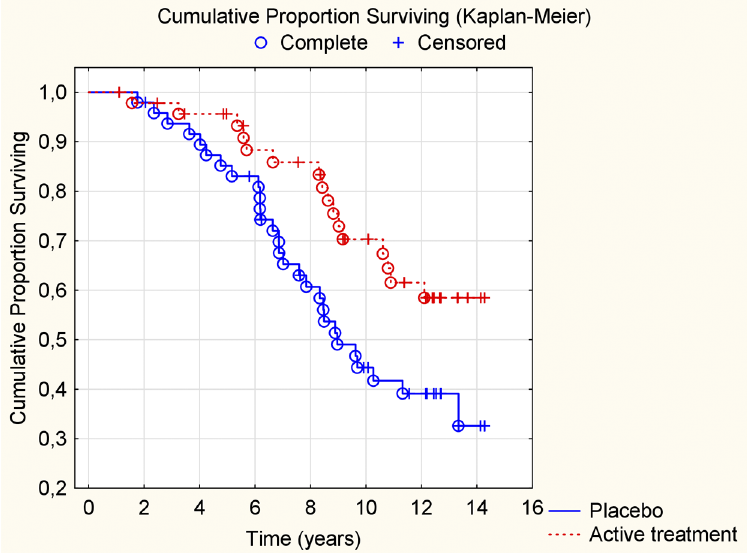
Fig 4. Kaplan-Meier graph illustrating cardiovascular mortality in participants with diabetes during a follow-up period of 12 years of those supplemented with selenium and coenzyme Q10 versus placebo for four years on top of regular pharmaceutical